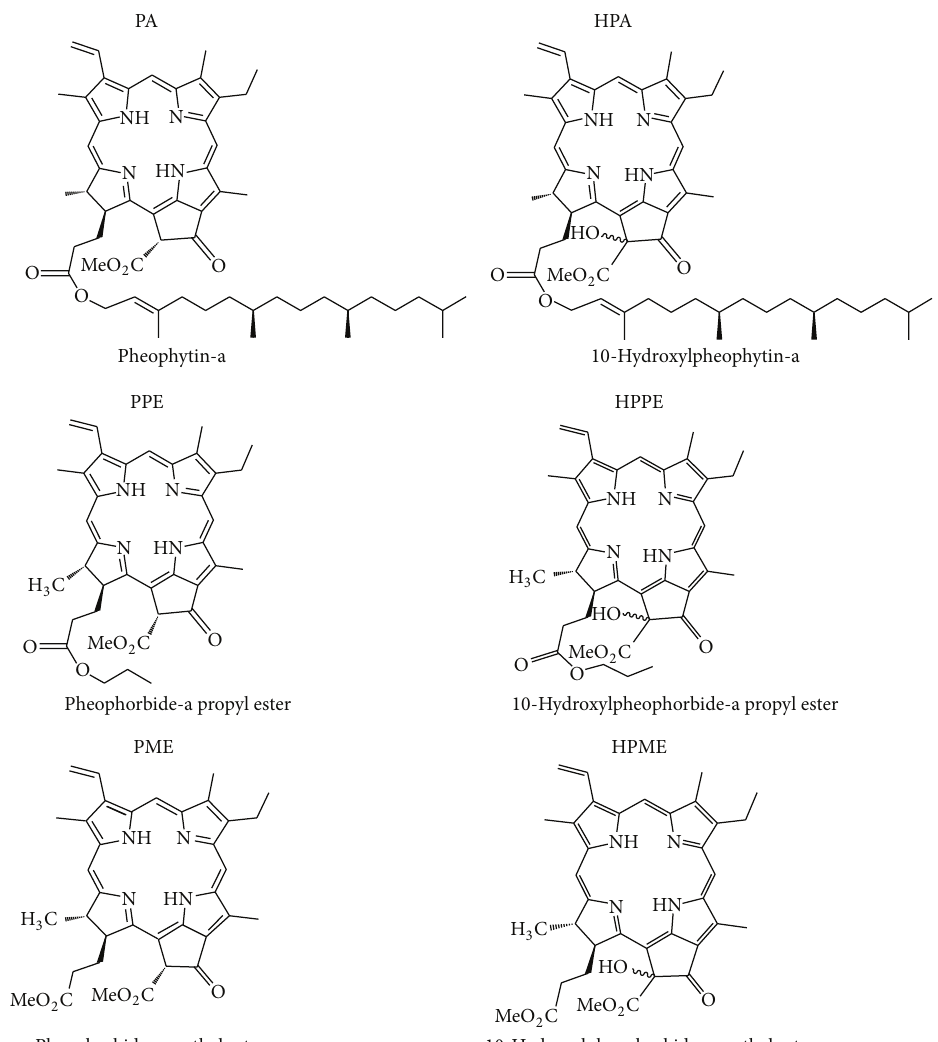
Figure 1: Molecular structures of pheophorbide-a derivatives